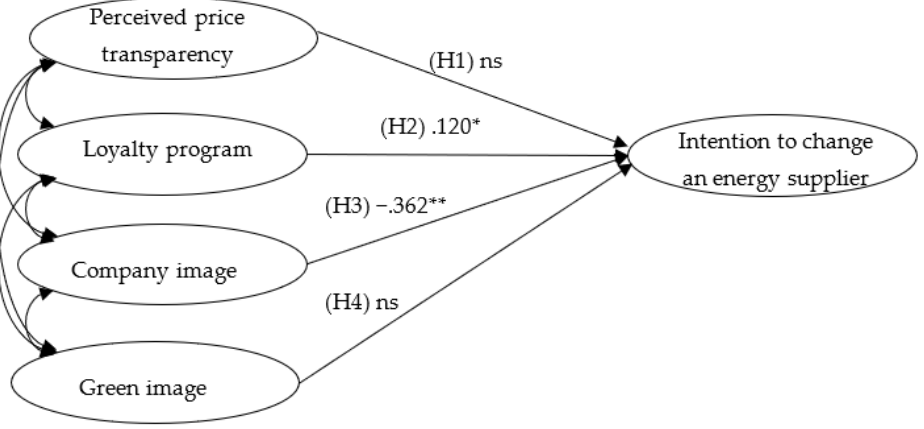
Figure 2. Summary of the research results (total research group). Note: ** p < .001; * p < .05, ns — nonsignificant. Table 4. Verification of research hypotheses (total research group).